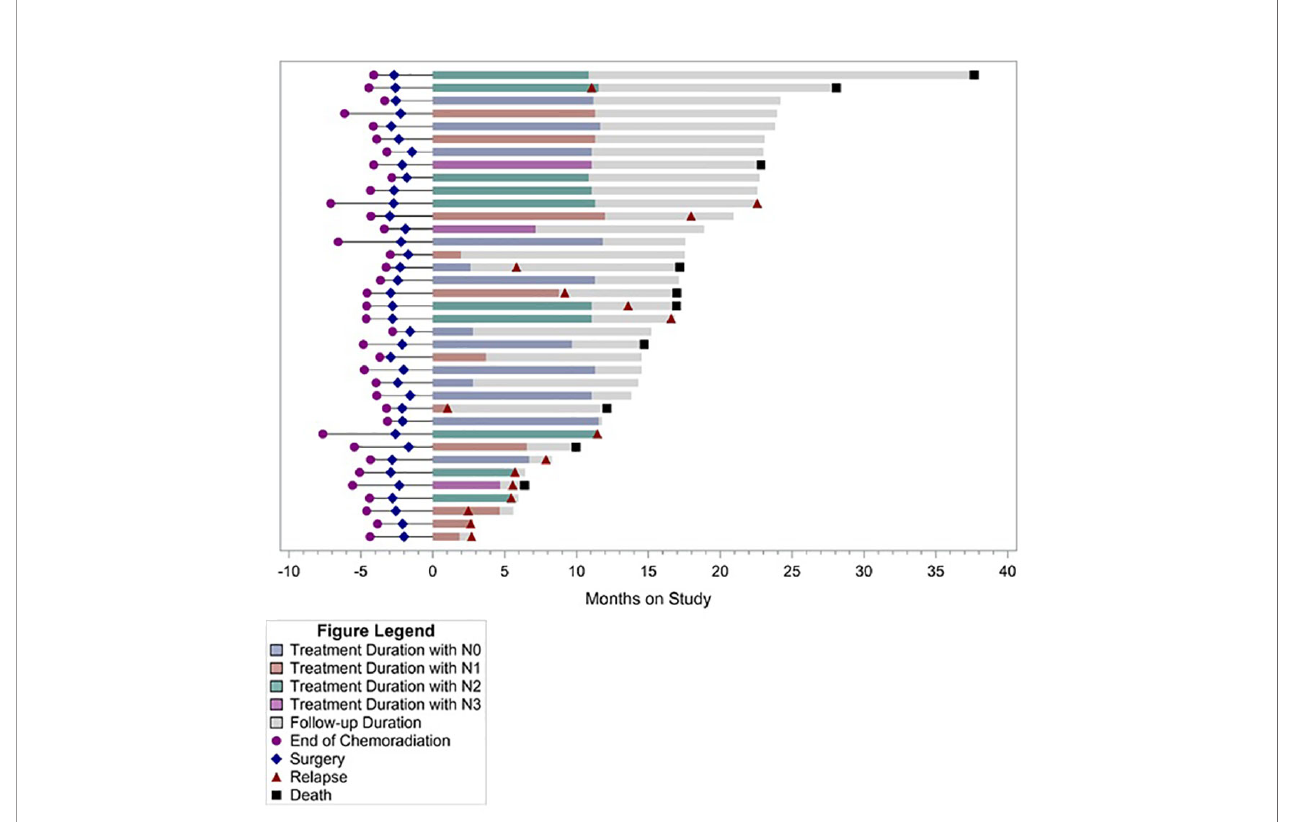
FIGURE 2 | Treatment duration, relapse, and follow-up based on pathologic lymph node status.